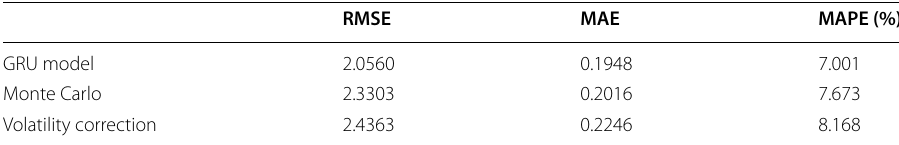
Table 9 The out-of-sample performance of the different methods